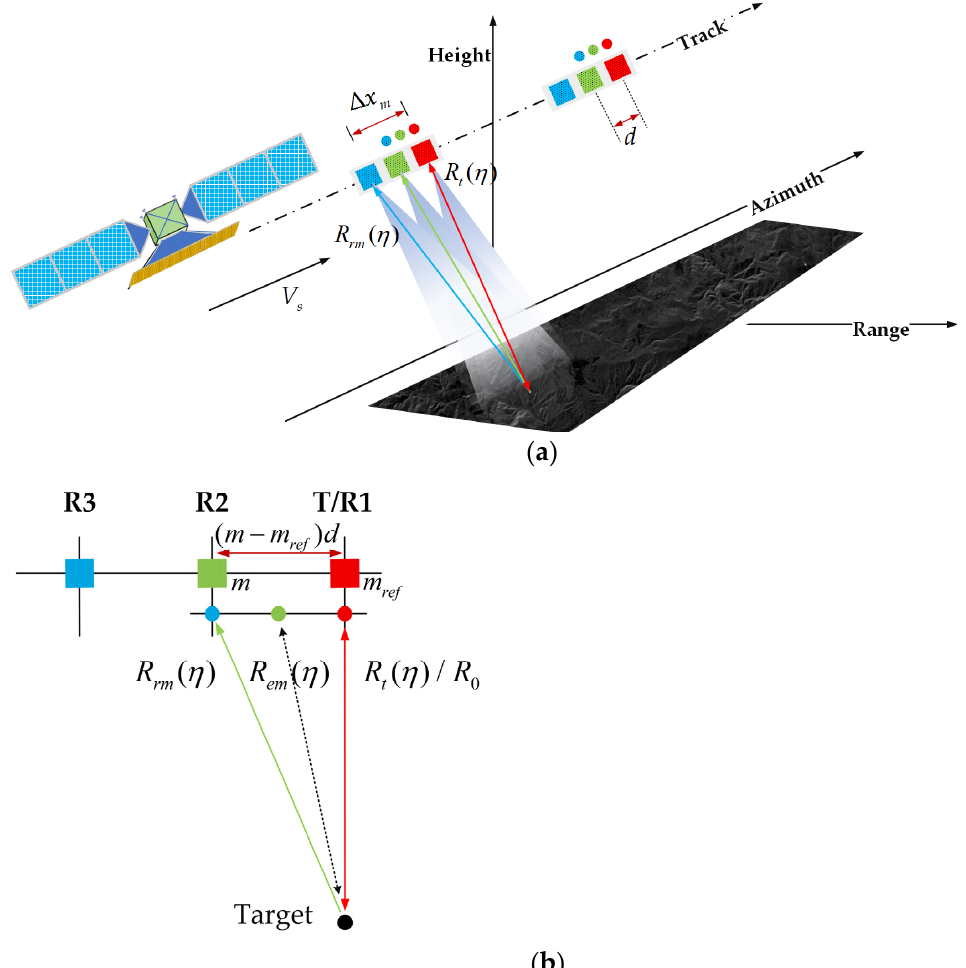
Figure 1. Illustration of the AMC SAR system. ( a ) Imaging geometry of AMC SAR; ( b ) EPC distribution. The azimuth spectrum of the reference channel is denoted by S ref ( f η ) .